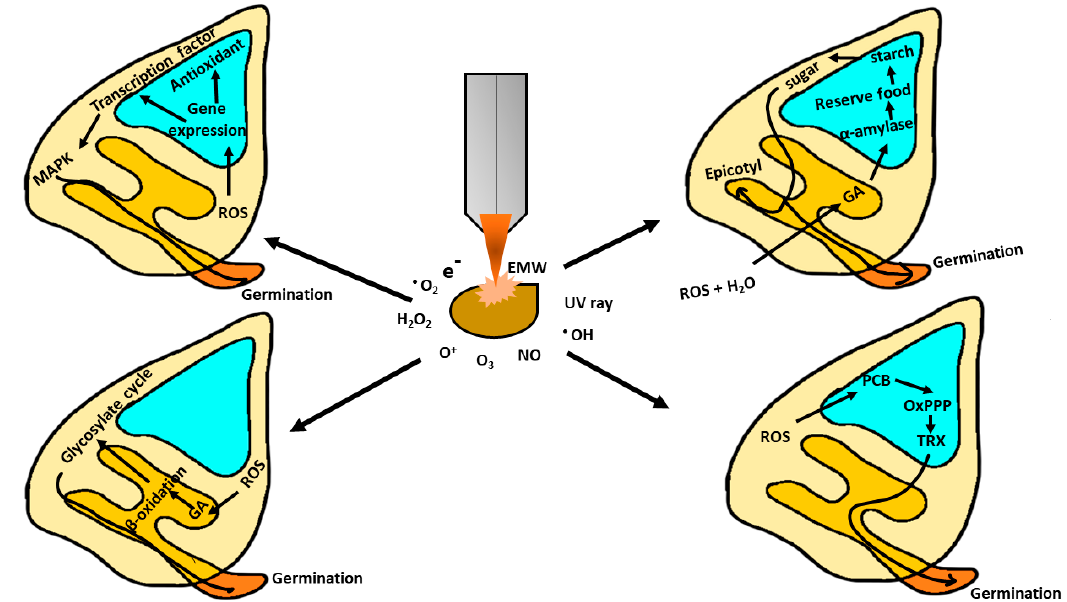
Figure 1. Plausible events of seed germination initiated by plasma seed priming. Plasma treatment causes mechanical damage and facilitates a redox environment for the seed. This redox environment induces different pathways of seed germination. EMW: Electromagnetic wave, GA: Gibberellic acid, MAPK: Mitogen activated protein kinase, OxPPP: Oxidative pentose phosphate pathway, PCB: Protein carbonylation, TRX: Thioredoxin.